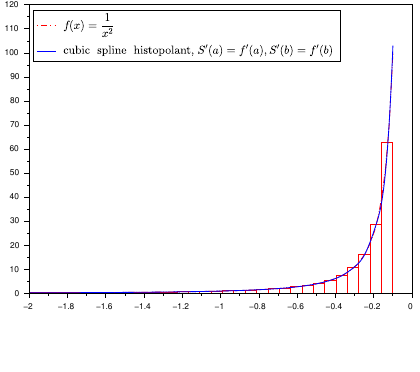
Figure 5. Cubic spline histopolant for n =